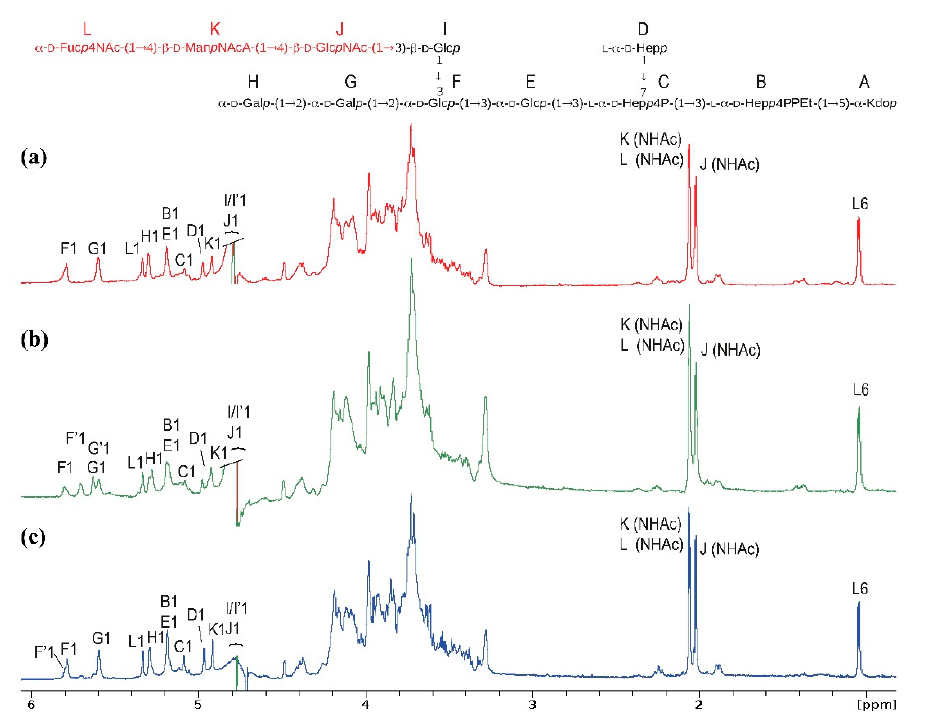
Figure 3. The 600 MHz 1 H Nuclear Magnetic Resonance (NMR) spectra of the [ECA]-core OS glycoforms identified in fractions 5 of ( a ) E. coli R1; ( b ) E. coli PCM 209 (O39); ( c ) S. sonnei phase II LOS preparations [7,8]. The ECA repeating unit is colored in red. The capital letters refer to carbohydrate residues of the [ECA]-core OS, as shown in the inset structure. Letters with a prime sign denote residues of trace amounts of the core OS devoid of ECA. Chemical shift assignment for E. coli R1 is present in Table 2.